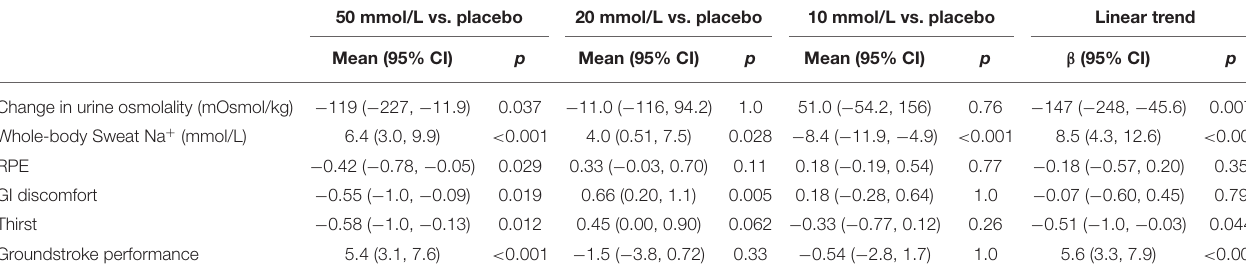
TABLE 2 | Mean differences (95% CI) in outcomes between experimental conditions. 50 mmol/L vs.